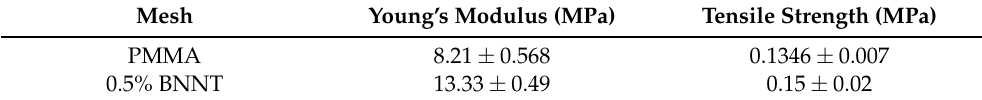
Table 1. The average tensile strength properties of the PMMA and BNNT-PMMA fiber mesh. Mesh